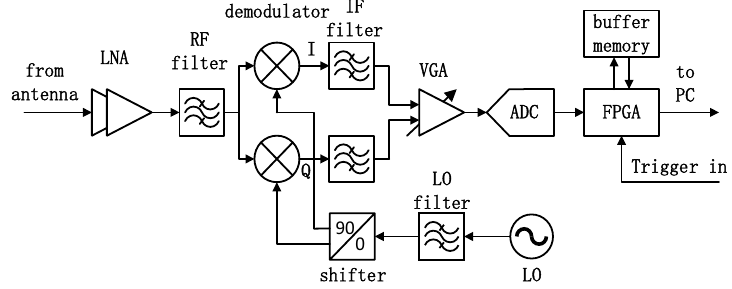
Figure 6. Hardware architecture of the receiver.